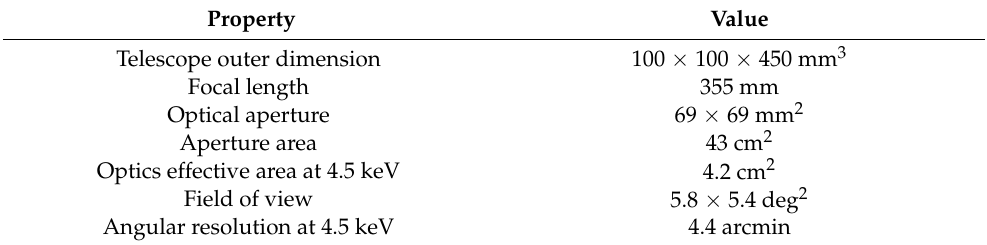
Figure 3. X-ray localization refinement/monitor Lobster Eye telescope design concept. Main parts are represented by LE X-ray optics module, including frame ( right ), optical tube, and detector part with electronics board ( left ). Table 2. Parameters of Lobster Eye X-ray localization refinement telescope/monitor system. Given angular resolution is resolution of optics, not taking into account attitude control